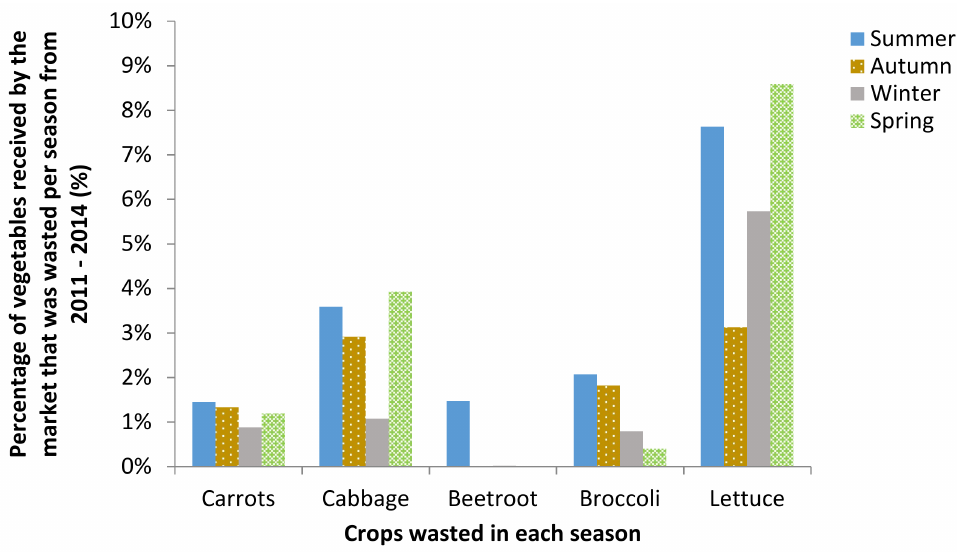
Figure 3. Percentage of crops received by the Tshwane Fresh Produce Market from 2011–2014 that was